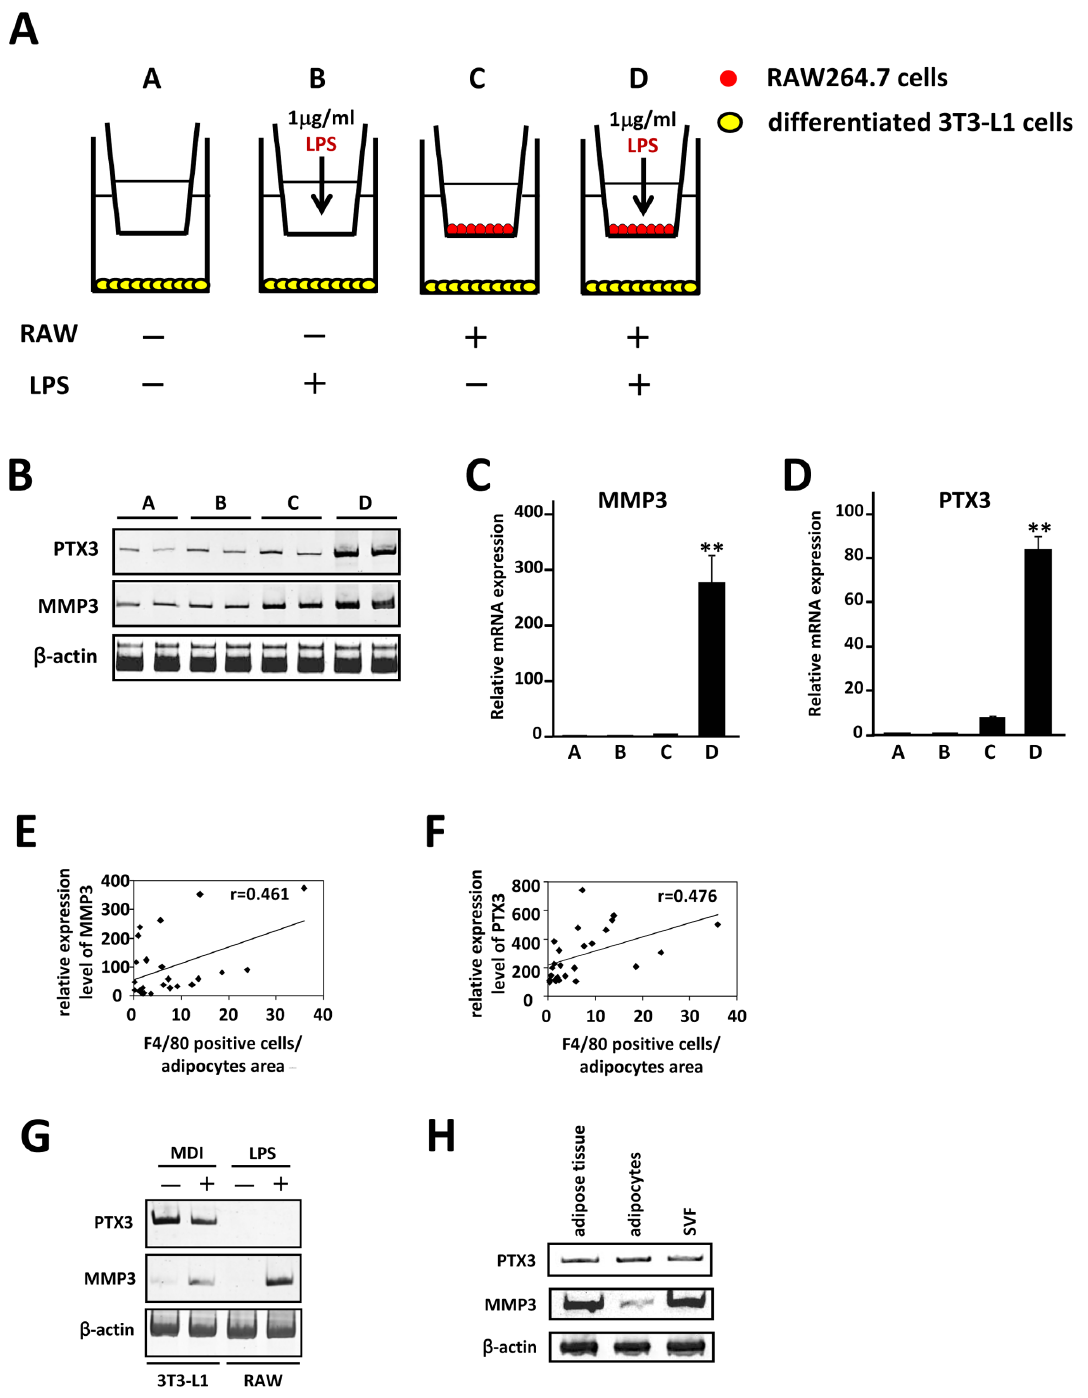
Figure 3. PTX3 and MMP3 expression in adipocytes is affected in the presence of activated macrophages. A , Illustration of the coculture system composed 3T3-L1 adipocytes and RAW264.7 cells is shown. B , Semiquantitative RT-PCR was performed to determine mRNA levels of PTX3 and MMP3 . The level of b -actin ( b -actin ) transcript was used as a control. C , D , Total RNAs from 4 groups was extracted and subjected to quantitative PCR to examine mRNA expression level of PTX3 and MMP3 . All values are normalized to b -actin levels. The data (mean 6 S.E.) are representative of two independent experiments. ** P , 0.01 compared with those of group C. E , F , The relative mRNA expression level of each gene was determined by quantitative PCR and normalized to b -actin level. Pearson’s correlation coefficient showed a positive correlation between MMP3 and PTX3 mRNA levels and number of F4/80 positive cells in adipose tissue of mice fed HFD. G , H , Semiquantitative RT-PCR was performed to determine mRNA levels of PTX3 and MMP3. 3T3-L1 preadipocytes were treated with MDI for 48 h and differentiated into mature adipocytes as described under ‘‘Materials and Methods’’. RAW264.7 cells were stimulated with 1 m g/ml of LPS for 18 hr. Mature adipocytes and SVF were isolated from white adipose tissue of HFD mice as described under ‘‘Materials and Methods’’.